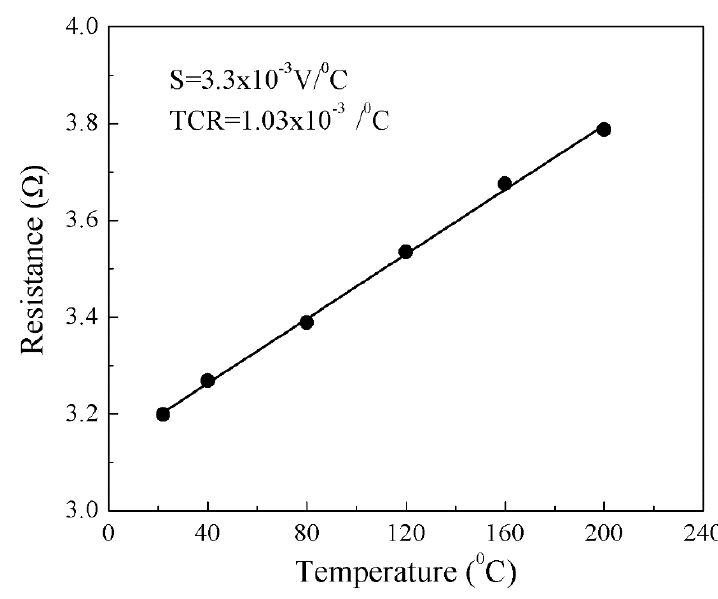
Figure 5. Resistance vs. temperature of CNT film.